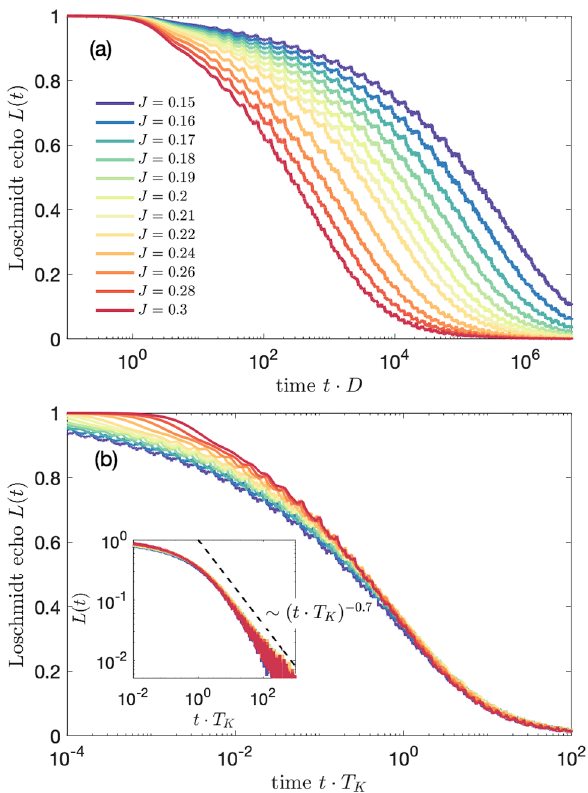
Figure 6. ( a ) The Loschmidt echo L ( t ) for quantum quench in the coupling strength J 1 = J 2 ≡ J , starting from J = 0 to the value shown in the legend. ( b ) The Loschmidt echo plotted vs time rescaled with the Kondo temperature T K , with T K = D exp ( − 1 / J ρ) . The inset presents the universal behavior for t · T K > 1 , where L ( t ) ∼ ( t · T K ) − 0.7 . In calculations we have used the following NRG parameters: N K = 14000 and (cid:31) = 1.6 .